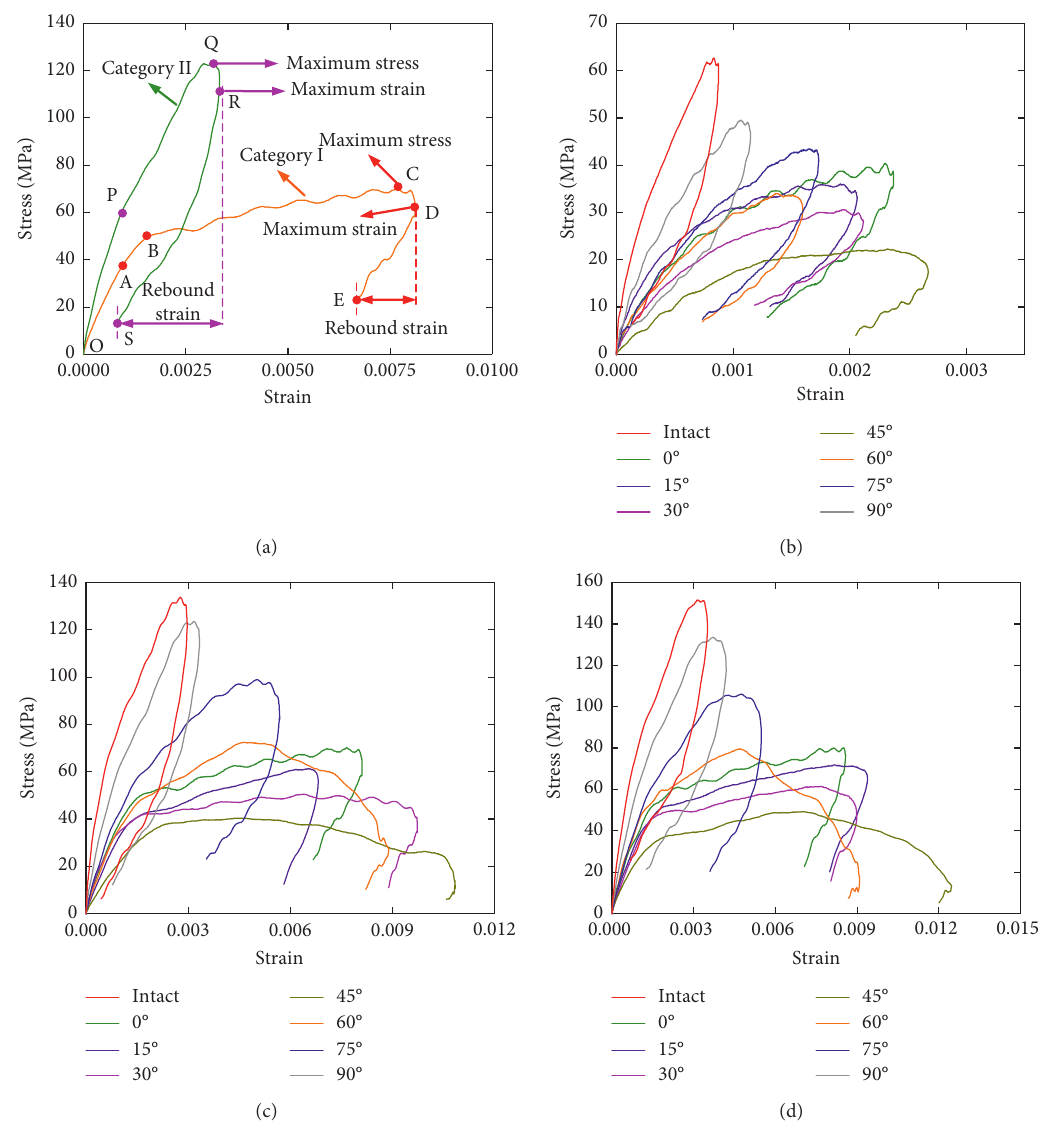
Figure 3: Stress–strain curves of intact specimens and jointed specimens. (a) Subsection methods of stress–strain curve; (b) the average strain rate _ ε � 30s − 1 ; (c) the average strain rate _ ε � 85s − 1 ; and (d) the average strain rate _ ε � 105s − 1